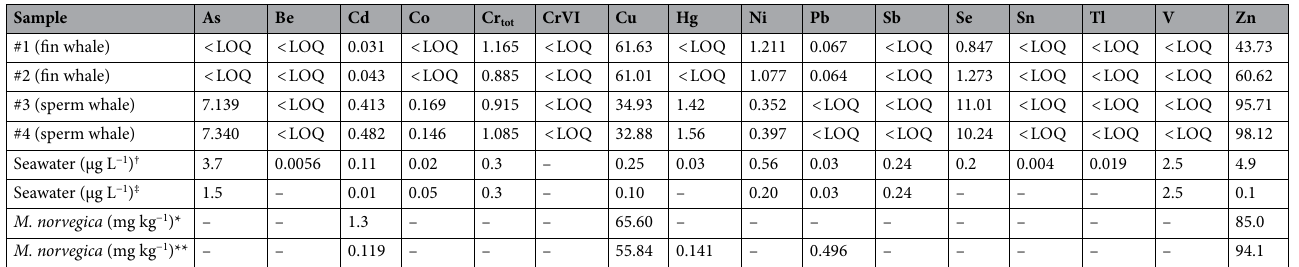
Table 3. Average metal concentration (mg kg −1 dry matter) in faecal samples from fin and sperm whales. The concentration of some of these metals in seawater (μg L −1 ) and in Meganyctiphanes norvegica (mg kg −1 dry matter) have been reported only for comparison. LOQ = limit of quantification (0.01 mg kg −1 ). † Data from Bowen (1979). ‡ Data from Chester (2000). *Data from Fowler 52 . **Data from Fossi et al. 53 ,